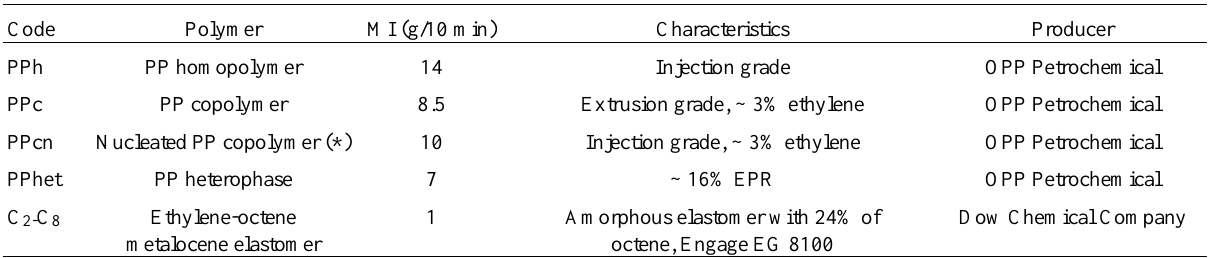
Table 1. Polymers used in this work and some of their characteristics.